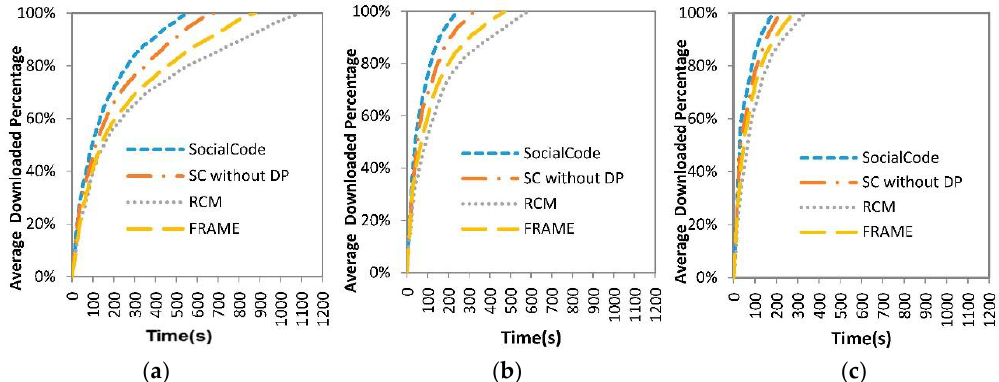
Figure 12. Average downloading percentage vs. the number of nodes ( a ) 3468 nodes; ( b ) 867 nodes; ( c ) 216 nodes.